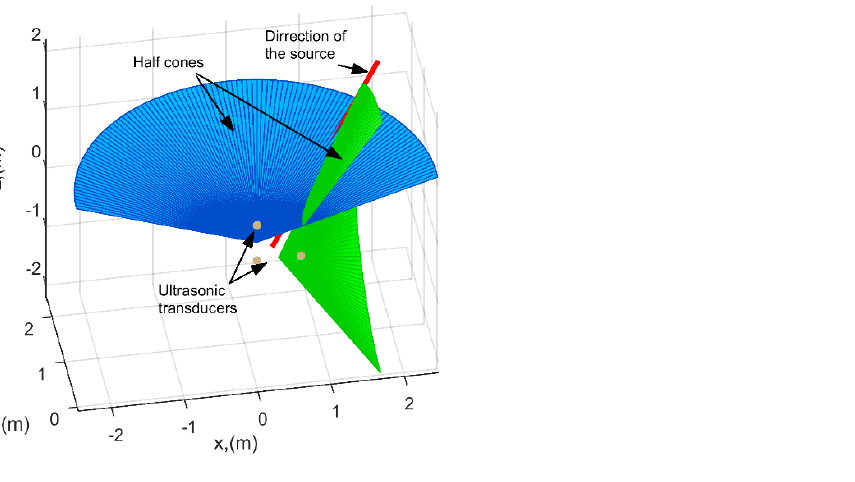
Figure 7. Two cones determining direction to the expected source of acoustic noise. and , situated in vertical direc- tion (along z axis), enable us to determine the angle by creating another cone 𝑅𝑅 1 ( 𝑥𝑥 1 , 𝑦𝑦 1 , 𝑧𝑧 1 ) 𝑅𝑅 3 ( 𝑥𝑥 3 , 𝑦𝑦 2 , 𝑧𝑧 3 ) (blue cone in Figure 7) with the vertex in the middle point between the vertical transducers 𝛼𝛼 𝑆𝑆13 𝐶𝐶 13 and the axis coinciding with line connecting these receivers. Note that for the better un-